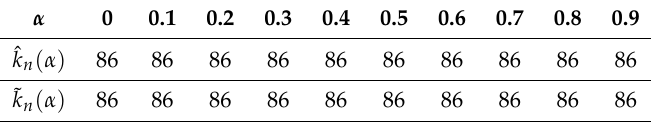
Table 3. The values of ˆ k n ( α ) and ˜ k n ( α ) based on Tesla’s returns data. α